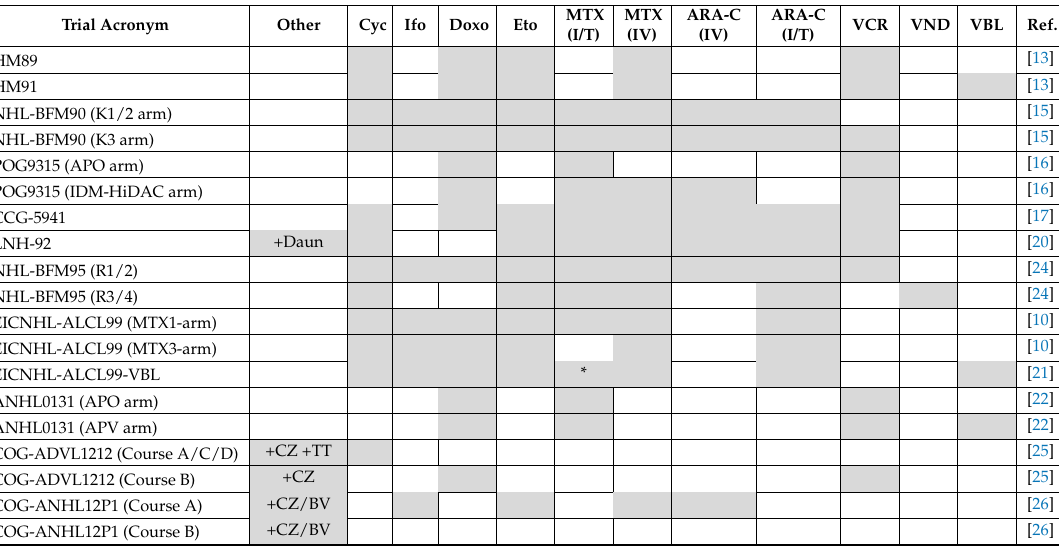
Table 2. Treatment strategies for childhood ALCL. ARA-C = cytarabine; BV = brentuximab vedotin;